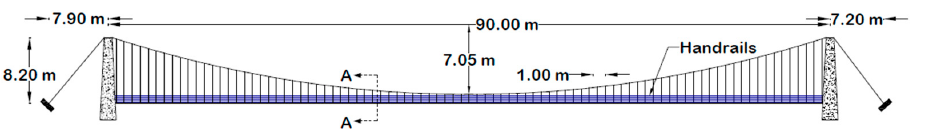
Figure 5. Cross-sections and dimensions of the footbridge structural elements (in mm). 3. Experimental Campaigns and Operational Modal Analysis This section describes the experimental campaigns carried out in 2019 and 2021 with the aim of identifying the footbridge’s dynamic properties and measuring the footbridge’s dynamic response under the dynamic excitation of a single pedestrian. 3.1. Ambient Vibration Testing Four ambient vibration tests with different measurement setup arrangements were conducted on the footbridge to detect its dynamic characteristics. Figure 6a shows the positions of accelerometers in the 4 setups. Suspended footbridges are characterized by extremely low natural frequencies, so the modes at risk of human-induced vibrations are usually higher modes, whose shapes are difficult to be correctly identified unless a great number of sensors are installed. Setup 1 was implemented in 2019, while the other three measurement setups were adopted in 2021 to identify more accurately the mode shapes of the footbridge. The low-cost equipment used for the tests included a 14-channel Labjack U6 data acquisition system with 10 TE Connectivity 4030 signal conditioned MEMS DC triaxial accelerometers that are able to measure accelerations in ±6 g range with a sensitiv- ity of 333 mV/g and a nominal 0–200 Hz bandwidth. Figure 6b shows the detail of the accelerometers’ mounting: they were bolted to an aluminum profile, which was rigidly connected through tight bands at the bottom of the hanger as close as possible to the joint with the transversal beam. The dynamic response of the footbridge was measured at 10 different locations in each measurement setup: vertical acceleration was measured at all the locations, while transverse accelerations were only at four locations (locations 1, 3, 7, and 9). In each meas- urement setup, the ambient vibrations were simultaneously recorded for one hour with a sampling frequency of 500 Hz.